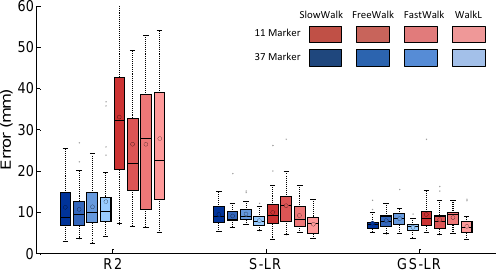
R2 Figure 4. Box plot of reconstruction errors obtained by principal component analysis (denoted as R2), sparse low-rank (S-LR) and group-sparse low-rank (GS-LR) for the 11 marker and 37 marker settings of the SlowWalk, FreeWalk, FastWalk and WalkL